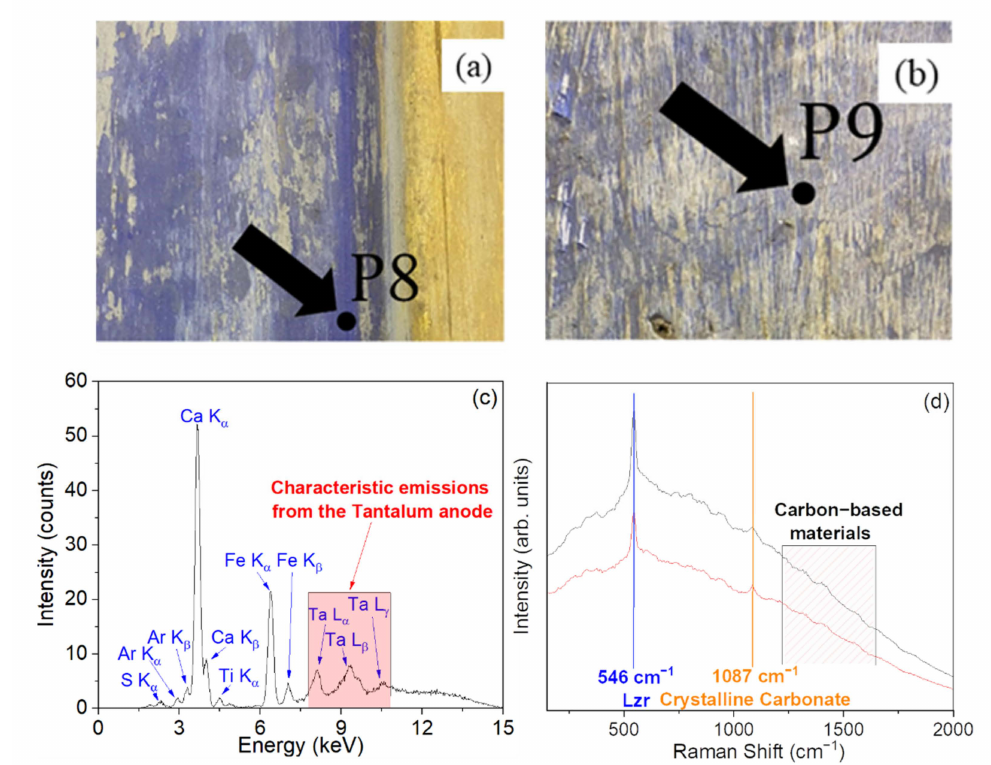
Figure 8. Photo of the point P8 (dark blue) ( a ). Photo of the point P9 (light blue) ( b ). XRF spectrum recorded on the point P8, reported as an example ( c ). Raman spectra recorded on the points P8 (grey line) and P9 (red line) ( d ). In the figure, Lzr: lazurite.